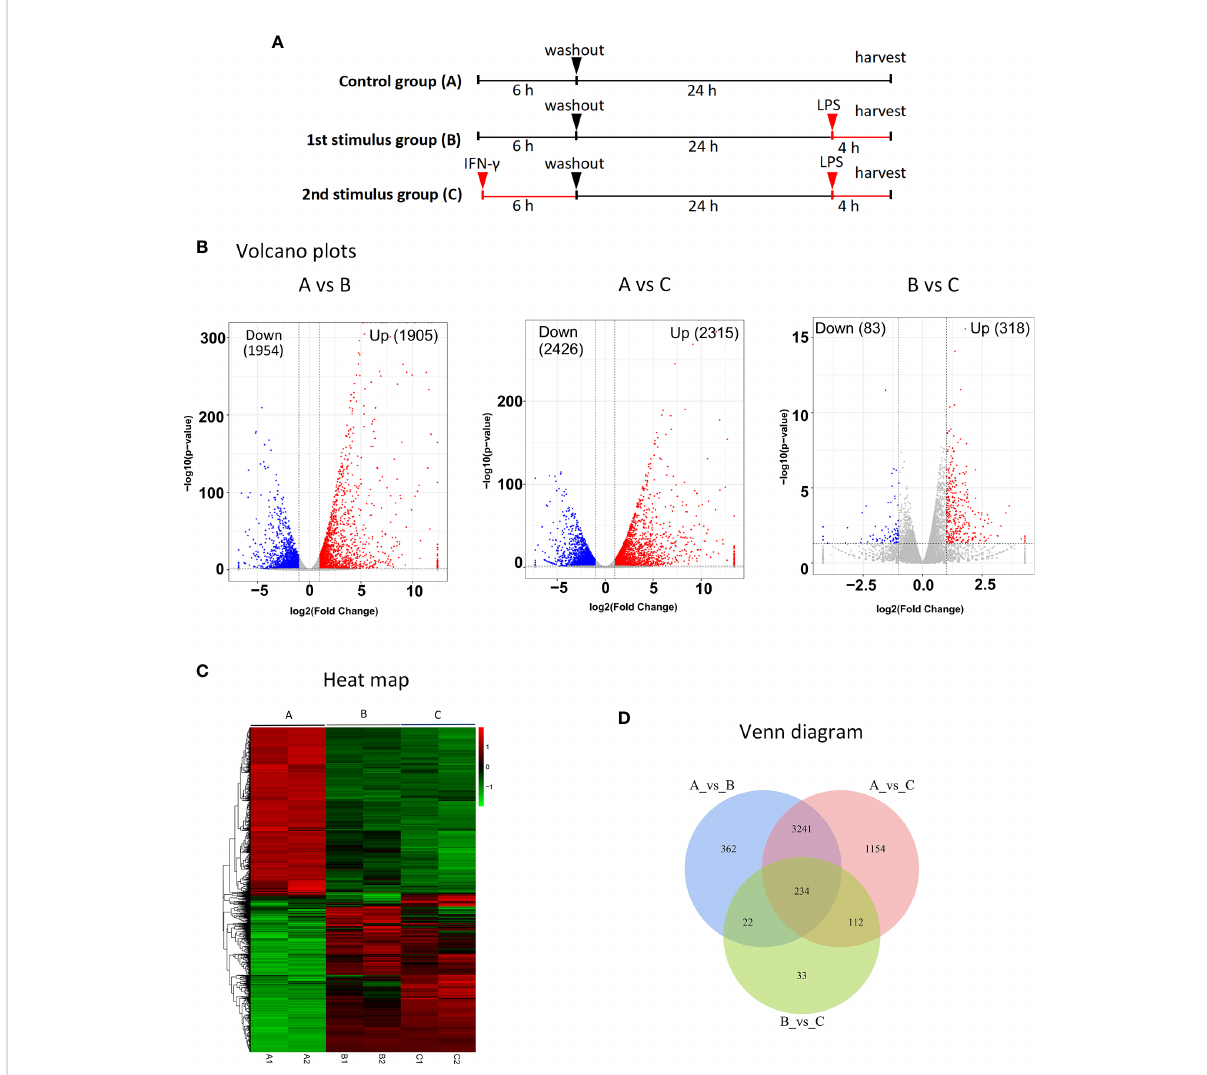
FIGURE 2 RNA-seq identi fi cation of DEGs after secondary stimulation of BMDMs in MRL/lpr mice (A) Experimental design for RNA-seq. The MRL/lpr mice ’ s BMDMs were divided into control group (A) , primary stimulation group (B) and secondary stimulation group (C) . Group A and group B were not treated, and group C was treated with IFN, washed after 6 hours, then incubated without IFN for 24 hours, and group B and group C were stimulated with LPS for 4 hours at the same time. DESeq was used for differential analysis of gene expression, and the conditions for screening DEGs were: |log2FoldChange| > 1, P-value<0.05. (B) Volcano plots of DEGs signi fi cantly up-regulated after secondary stimulation. Log2FoldChange is the abscissa and -log10 (p-value) is the ordinate. The horizontally dotted line shows the P-value=0.05 threshold, and the two vertical line(dotted) are the 2-fold interpretation difference thresholds in the image. In this group, red dots represent genes that are up- regulated, blue dots indicate genes that are down-regulated, and grey dots suggest genes that are not statistically different. (C) Clustering of different gene expression in six samples.The horizontal lines represent genes, each column is a sample, red represents high-expressed genes, and green represents low-expressed genes. Each group has two parallel samples, namely A1, A2, B1, B2, C1, C2. (D) Venn diagram of a total of 234 identical DEGs between the three datasets. Of these, 191 genes were up-regulated in all three